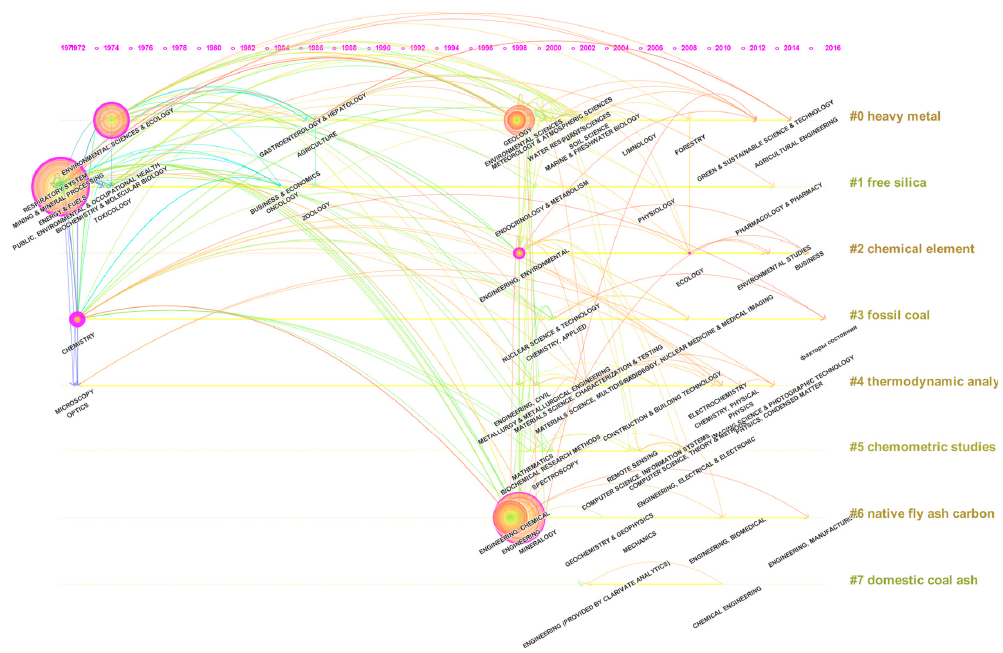
Figure 7. The TimeLine of categories of trace elements in coal and ash.